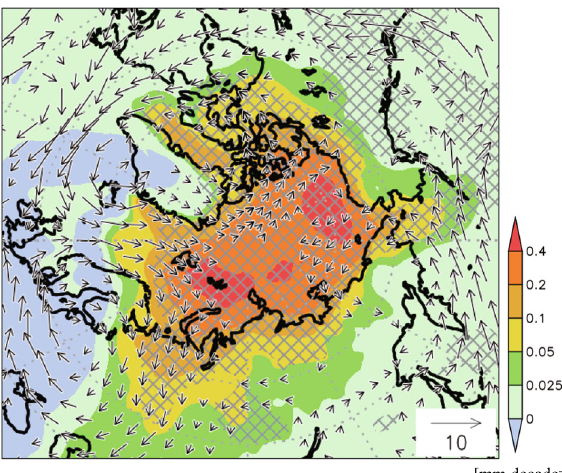
Fig. 3 Trend of Arctic moisture during September – December. Spatial distribution of the linear trends in Arctic moisture (mm decade − 1 ) and water vapor fl ux (kg m − 1 s − 1 decade − 1 ) during September – December, omitting values <1.0. The water vapor fl ux is for the accumulation of all moisture sources. Hatching denotes a trend statistically signi fi cant at the 95% con fi dence